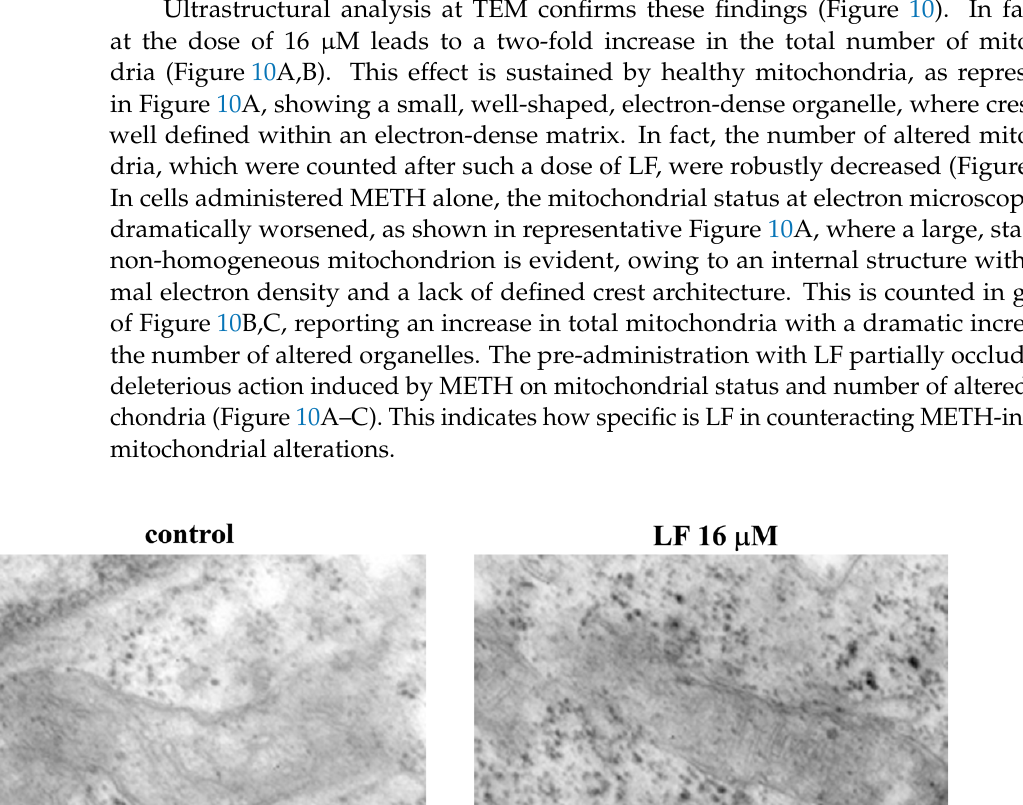
Figure 10. LF prevents METH-induced alteration of mitochondrial structure and number. ( A ) Representative micrographs showing mitochondria from a control cell and from cells treated with either LF, or METH, or combined LF + METH. Note the ultrastructure of well-preserved mitochondria from controls and LF-treated cells. After, METH mitochondria show crest fragmentation (arrows) and matrix dilution (*). These effects are attenuated by previous LF administration, which mitigates mitochondrial crest derangement (arrow). The histograms report ( B ) the number of mitochondria per cell and ( C ) the percentage of altered mitochondria following various treatments. * p < 0.05 compared with control; # p < 0.05 compared with METH. Scale bar = 90 nm.